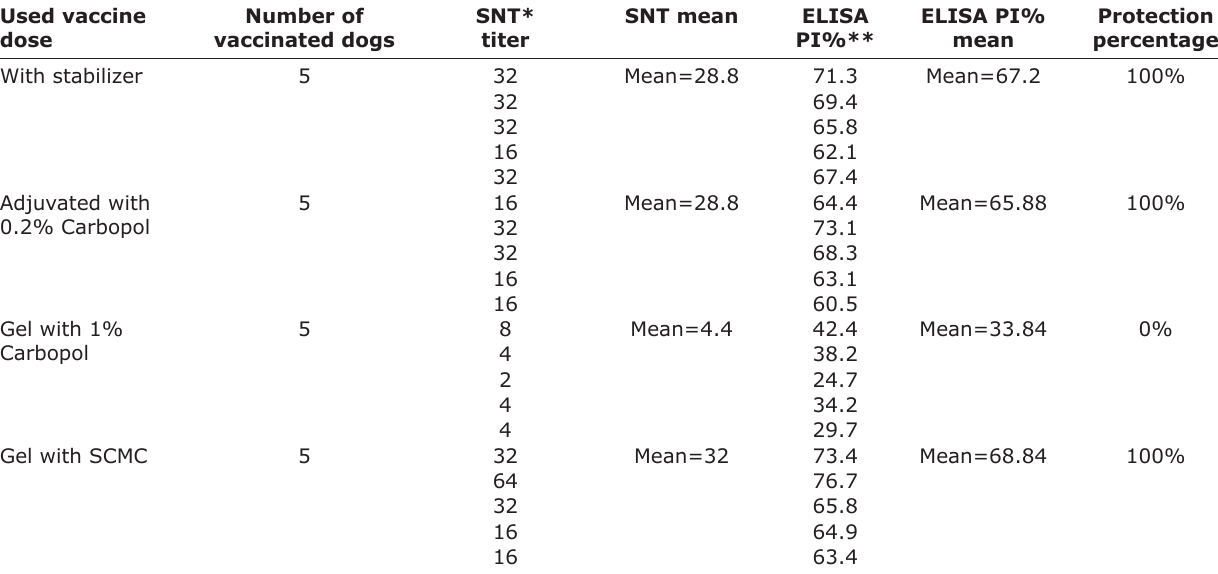
Table-2: Evaluation of the of the different prepared rabies vaccine formulae in the buccal cavity of dogs. Used vaccine